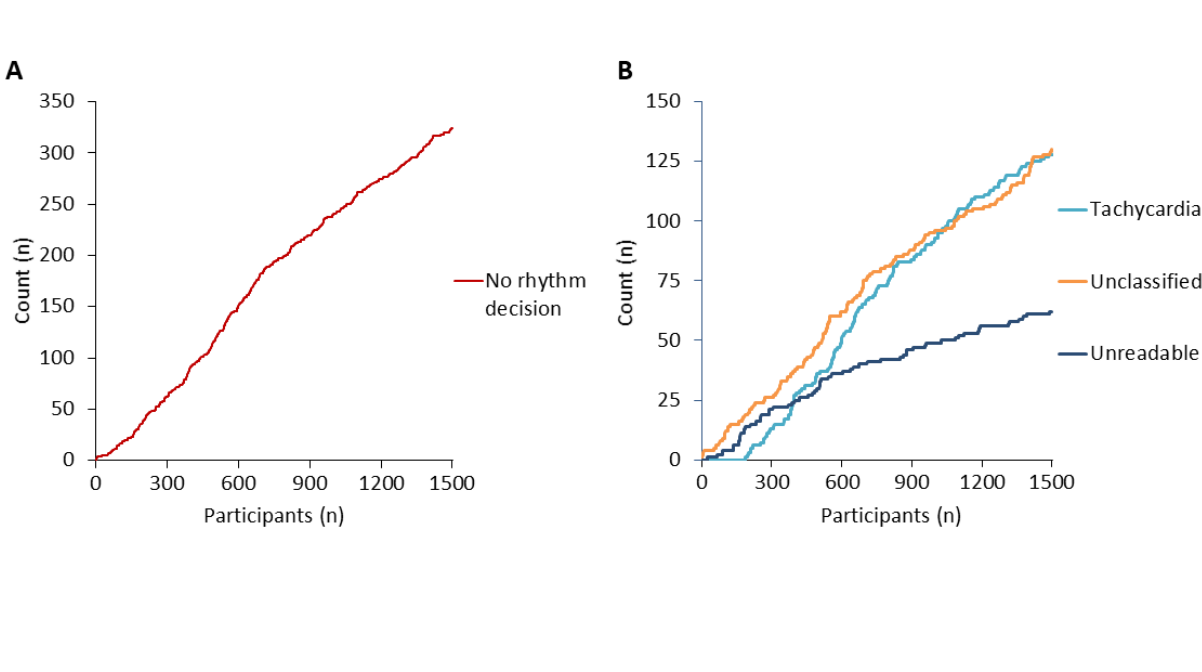
Figure 5. Cumulative occurrence and contributors to no rhythm decision from KardiaMobile’s automated algorithm on initial electrocardiogram tracing: (A) cumulative occurrence of no rhythm decision from initial electrocardiogram tracing and (B) occurrence of unreadable tracing was significantly reduced when compared with unclassified and tachycardia tracings with increasing patient